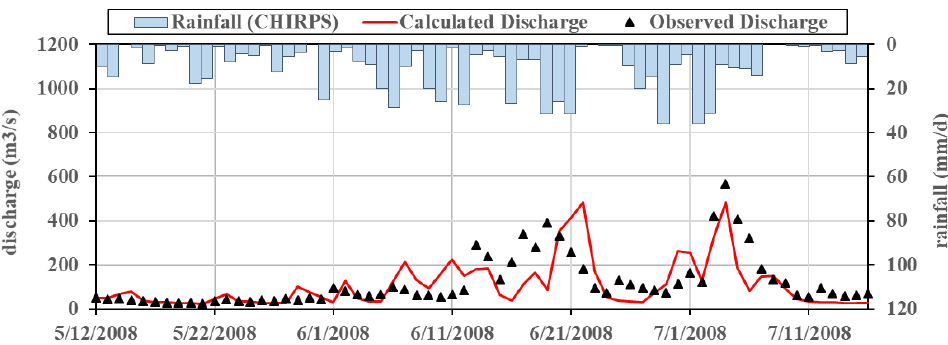
Figure 5. Event-based validation of river discharge at the Lacson station with CHIRPS, satellite- based rainfall during the annual maximum flood.